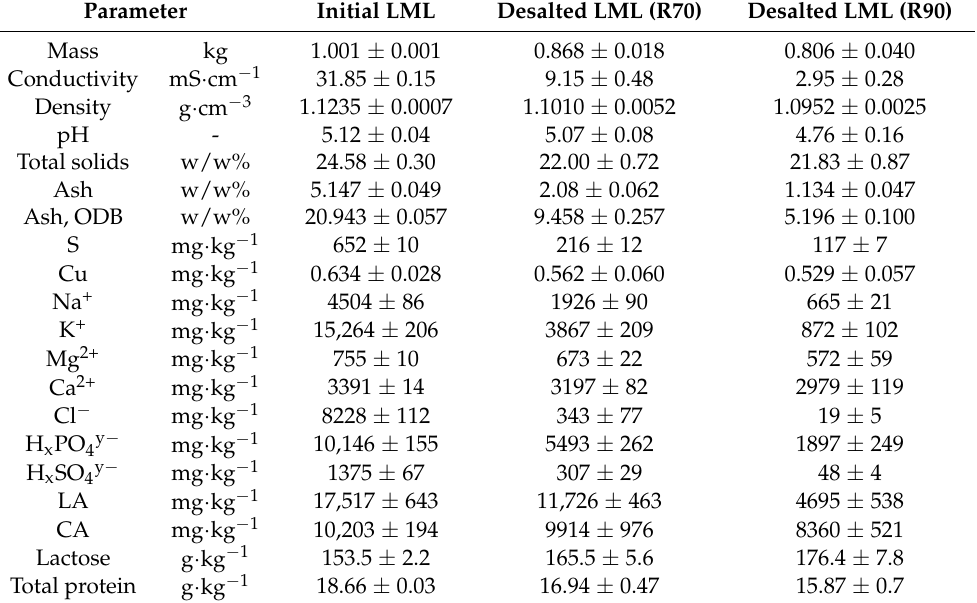
Data are the average of 4 repetitions with a confidence level of p = 0.95.